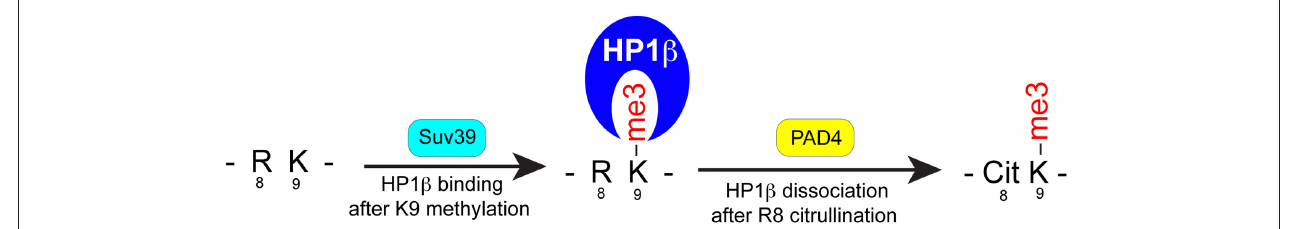
FIGURE 6 | Working model for the effects of H3Arg8 (R8) citrullination on the binding of HP1 β to H3K9me3. (1) Upon methylation of H3K9 by the methyltransferase (e.g., Suv39), HP1 β recognizes this modification and is recruited to a chromatin region to regulate heterochromatin structure